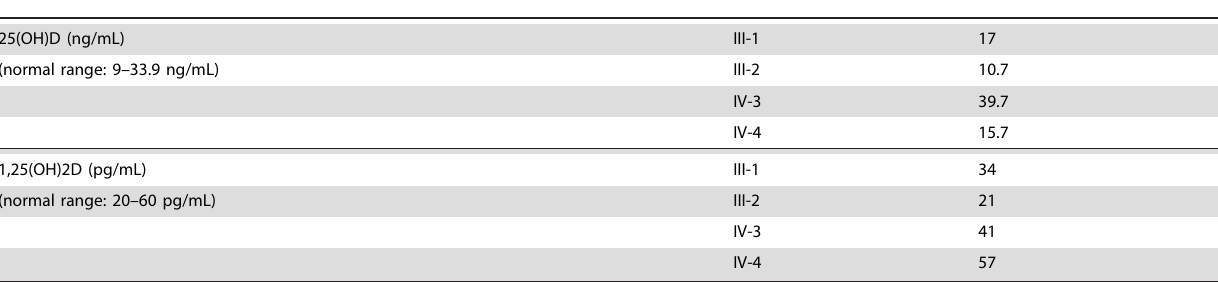
No significant differences in the serum concentrations of vitamin D (25 (OH) D and 1, 25 (OH) 2 D) were seen between the patients and the healthy control subjects. III-1: Not patient in this family; P: patients.